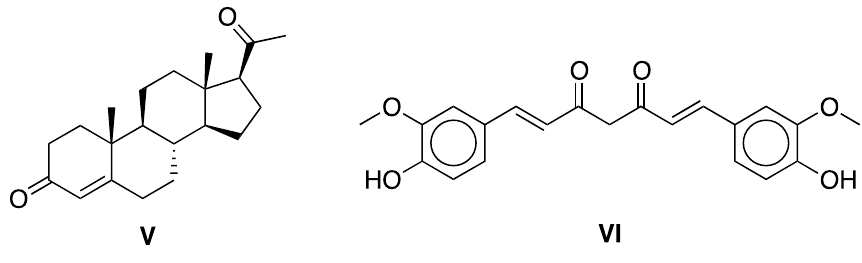
Figure 4. Archetypal drug for encapsulation assays: Progesterone ( V ) and curcumin ( VI ) Progesterone is a lipophilic drug used in menopausal hormone replacement therapy